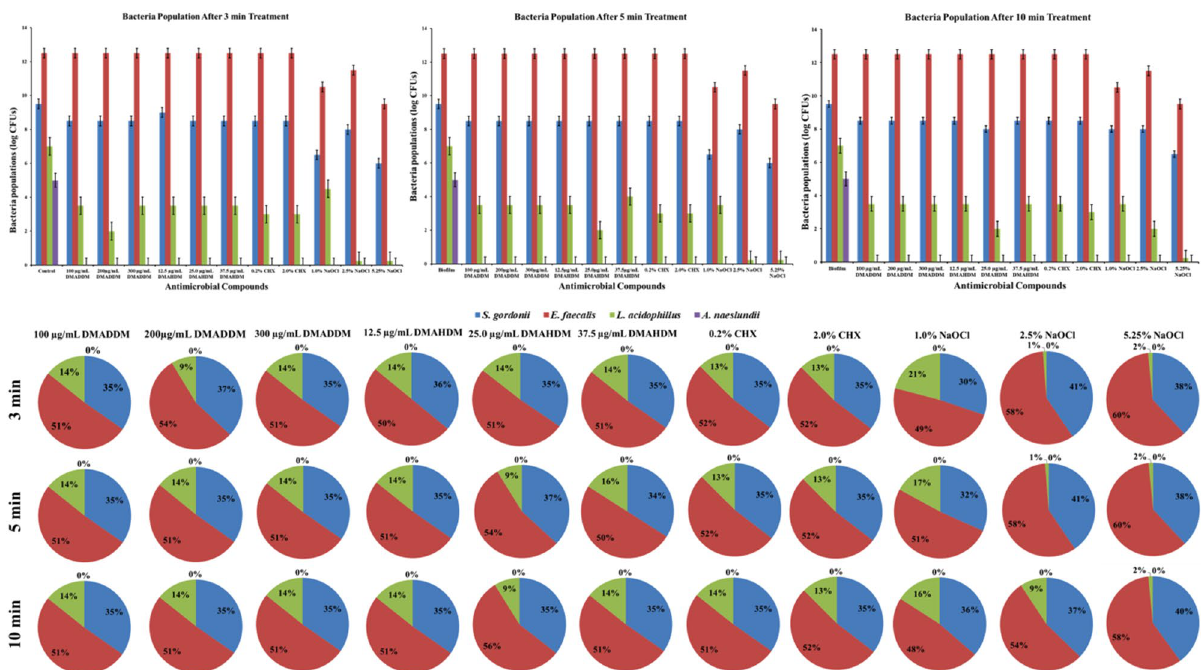
Figure 8. The compositions shift of A . naeslundii , L . acidophilus , S . gordonii and E . faecalis in biofilms after treatment with DMADDM, DMAHDM, CHX and NaOCl for 3 min, 5 min and 10 min. The composition